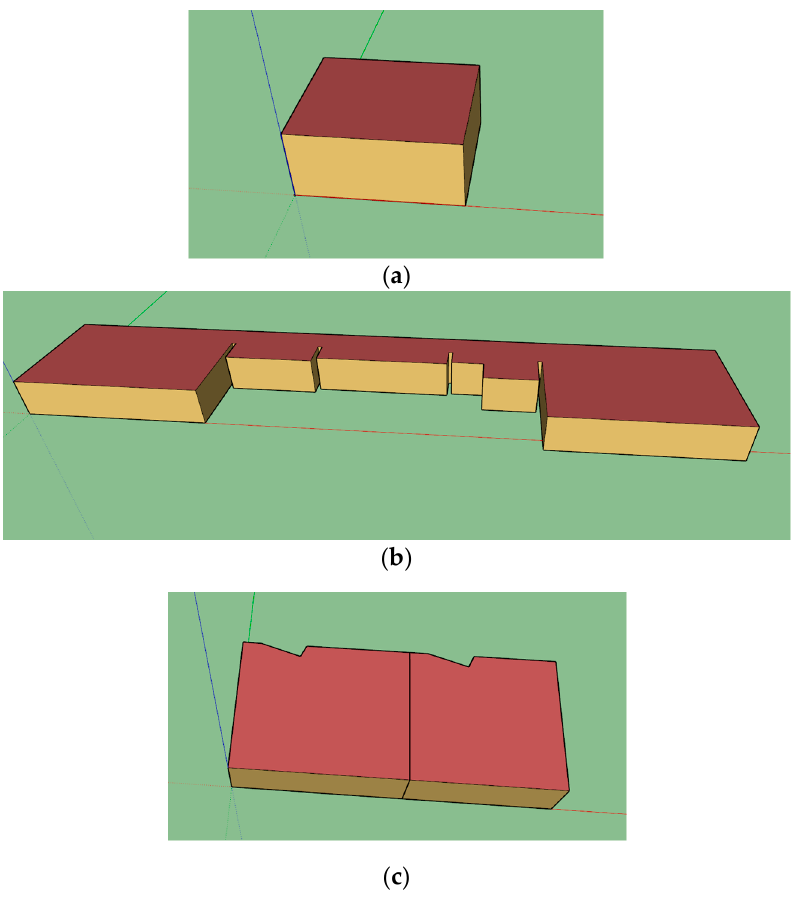
Figure 21. Manually generated models: ( a ) Scenario 1; ( b ) Scenario 2; ( c ) Scenario 3.